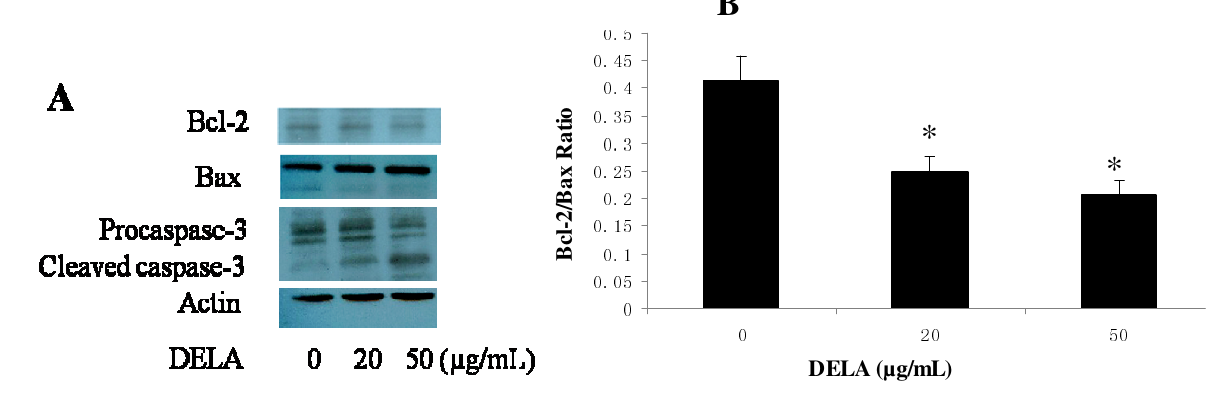
Figure 3. Western blotting analysis of Bax, Bcl-2, and procaspase-3 of the murine sarcoma S180 cells treated with 0, 20, and 50 µg/mL of DELA for 12 h. ( A ) Levels of Bcl-2, Bax, procaspase-3, and cleaved caspase-3, ( B ) Graphs showing changes in the ratio of Bcl-2/Bax in cells. The results are expressed as means ± SD (n = 3). * p < 0.01, compared with 0